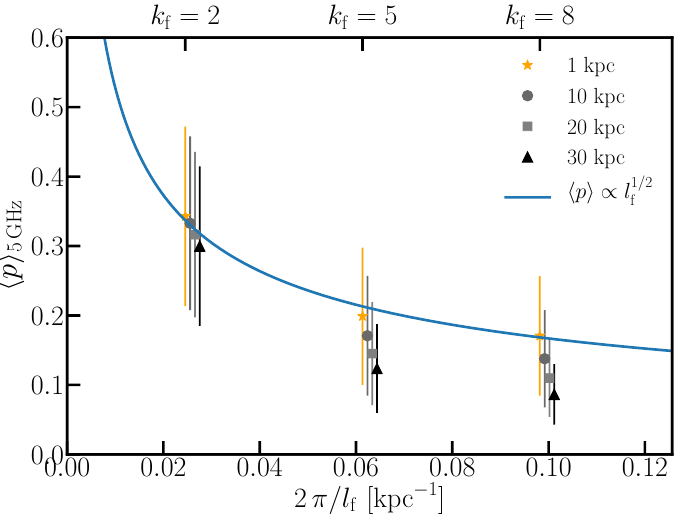
p , with the turbulence driving (cid:104) (cid:105) 5GHz p obtained by smoothing on (cid:104) (cid:105) ∝ l 1/2 p variation, same as in Figure 4 (left-hand f (cid:104) (cid:105)